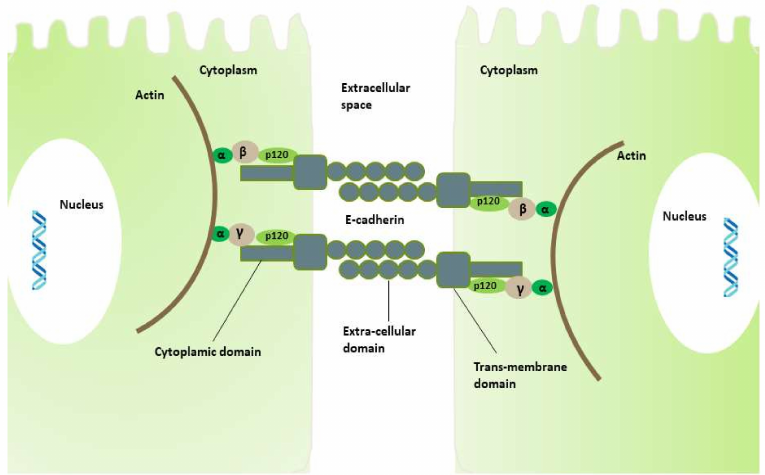
Figure 1. Cell–cell adhesion through E-cadherin. The extracellular domain of E-cadherin from adjacent cells is involved in cell adhesion and tight junction. The cytoplasmic domain forming a protein complex with catenins ( α -, β -, and p120-) regulates the cytoskeleton protein and actin, which is an important protein for normal cell